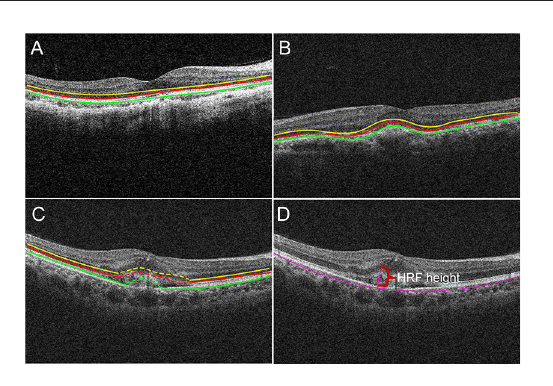
FIGURE2 The borders of the fundus structures were segmented by automated algorithm. Algorithm performs segmentation and determines the lateral macular retinal sublayer (A) , yellow line: external limiting membrane (ELM); red line: ellipsoid zone (EZ); green line: retinal pigment epithelium (RPE). The location of PM-CNV on optical coherence tomography images was classified as type 1 (B) and type 2 (C) . Hyperreflective foci (HRF) measurement: HRF height was the distance between